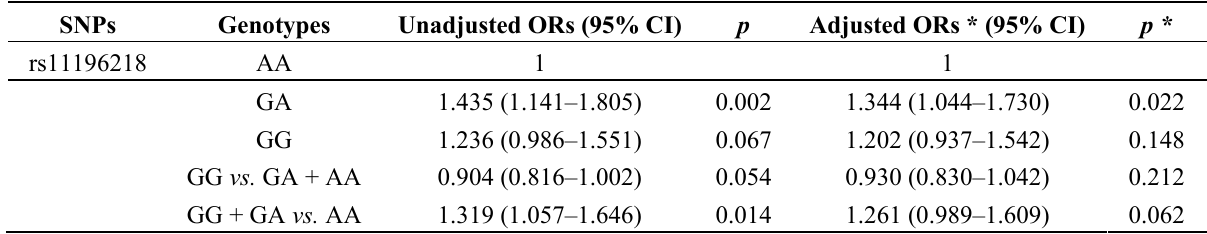
Table 6. Association of rs11196218 in TCF7L2 gene and T2DM in Han Chinese. SNPs